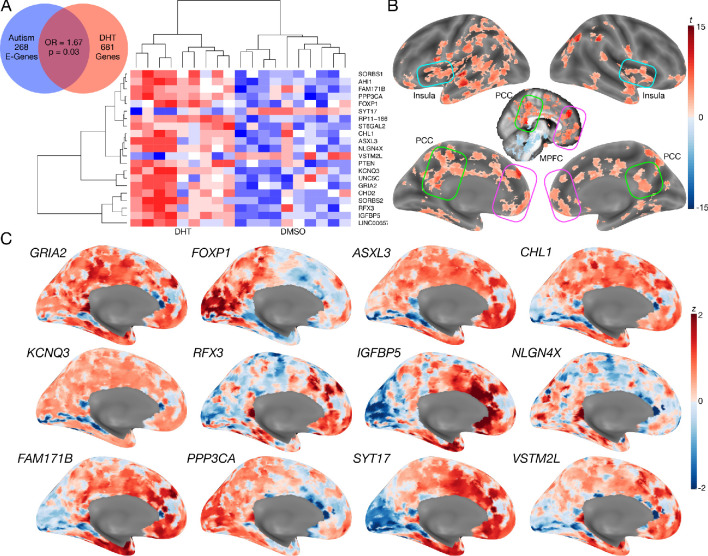
Autism-associated genes within excitatory neuronal cell types are enriched for genes differentially expressed by androgen hormones.Panel A shows a Venn diagram depicting the enrichment between autism-associated genes affecting excitatory neurons (Autism E-Genes) and DHT-sensitive genes. Panel A also includes a heatmap of these genes whereby the color indicates z-normalized expression values. The column dendrogram clearly shows that all samples with DHT treatment are clustered separately from the control (DMSO) samples. Each row depicts the expression of a different gene. Panel B shows a t-statistic map from a whole-brain one-sample t-test on these DHT-sensitive and autism-associated genes in excitatory neurons. Results are thresholded at FDR q < 0.01. Panel C shows spatial gene expression profiles on a representative surface rendering of the medial wall of the cortex for specific genes shown in panel B. Each map shows expression as z-scores with the color scaling set to a range of −2 < z < 2.